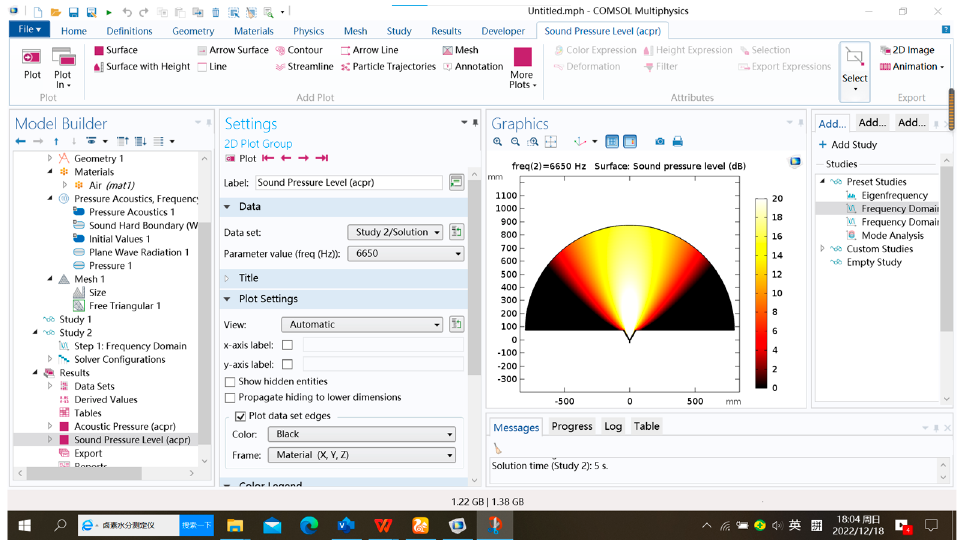
Figure A1. Simulation interface screenshots. Table A2. Detailed information of the experimental instrument.